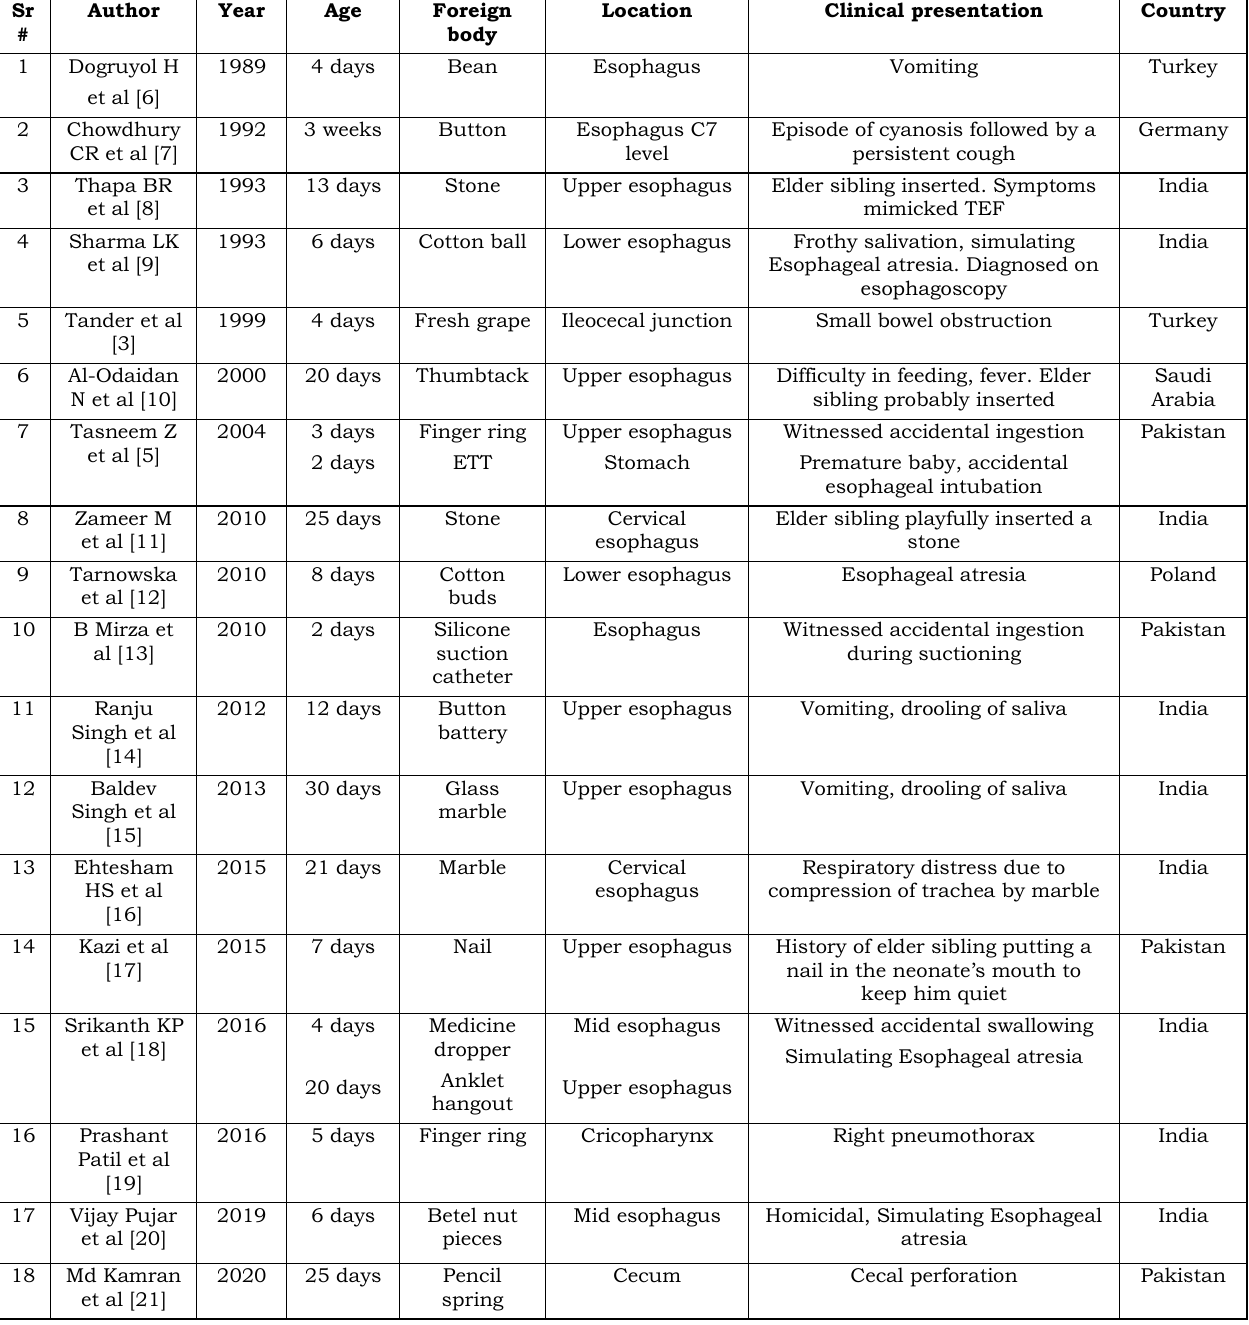
Table 1: Literature on ingested foreign bodies and bezoars in